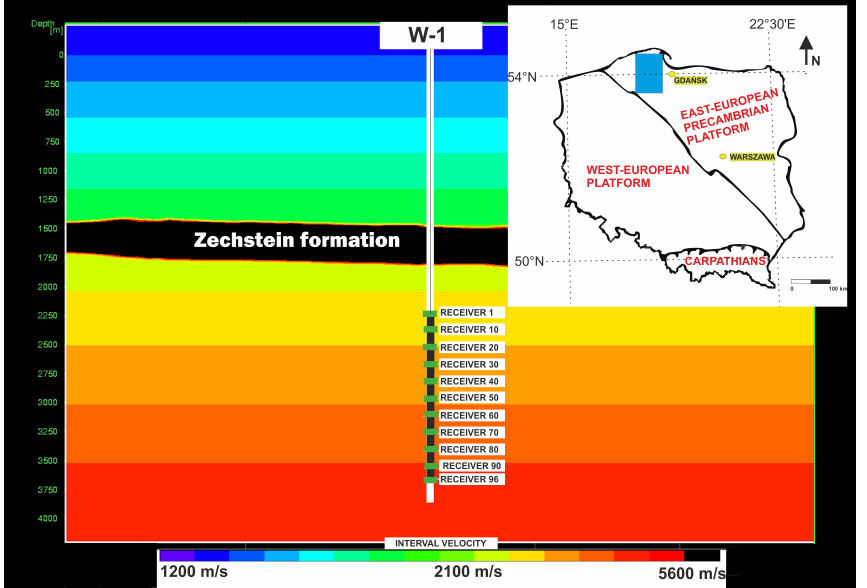
Figure 1. Location of W-1 well (blue rectangle) together with tectonic units and initial velocity model used for seismic depth migration ([9]